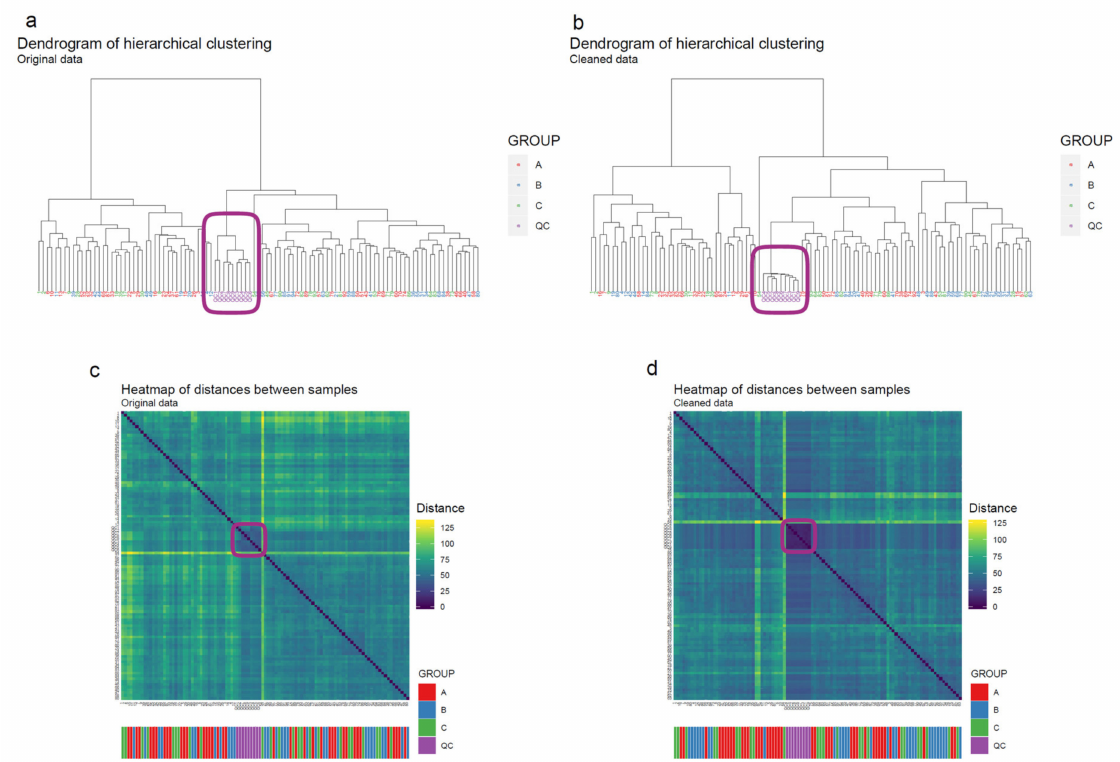
Figure 11. The hierarchical clustering algorithm clusters quality control (QC) samples together even before drift correction ( a ) whereas, after performing drift correction ( b ), the QC samples cluster more clearly together. In the heatmap after the drift correction ( d ) a QC “block” pattern (purple color code), is more clearly visible than in the heatmap before drift correction ( c